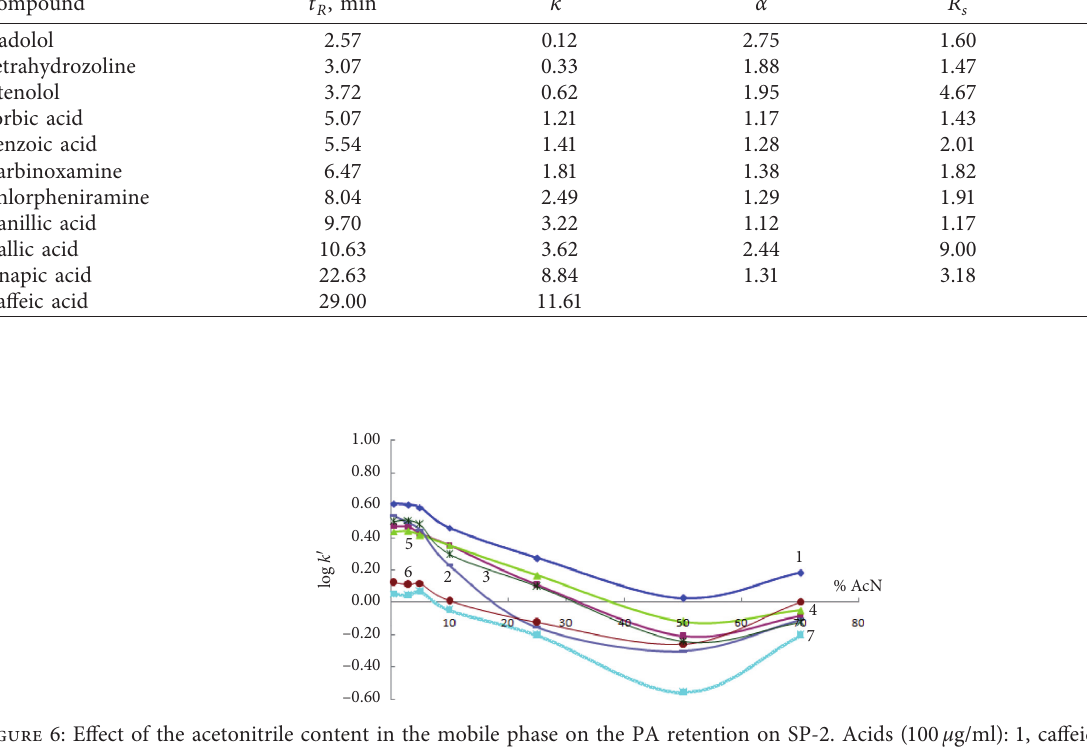
Table 3: Chromatographic parameters of the separation of a mixture of FCC and nitrogen-containing compounds. Compound